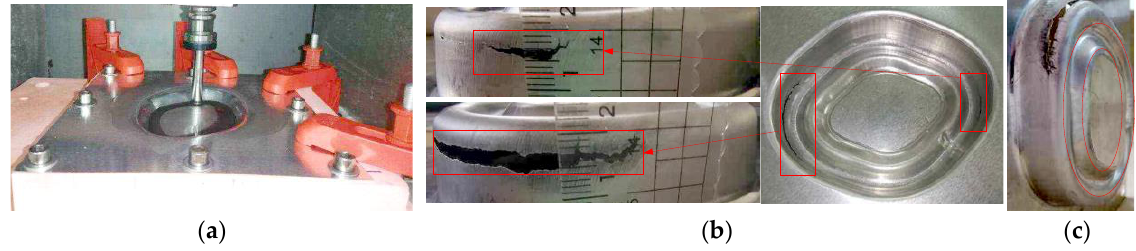
Figure 18. The traditional multi-stage forming: ( a ) the forming process; ( b ) the formed part; and ( c ) the bottom.